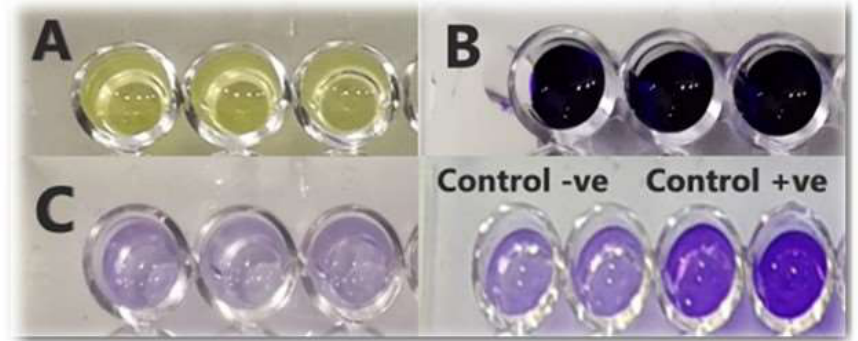
Figure 5: Anti-biofilm Efficacy of Cinnamon Oil Against K. pneumoniae Isolates by Tissue Culture Plate Method. (A) After 24 hours of incubation at 37°C, (B) During staining with 1% crystal violet, and (C) After dissolving adherent cells in 95% ethanol. The Negative control consists of (MIC value with TSBG) while the positive control consists of (bacterial sample with